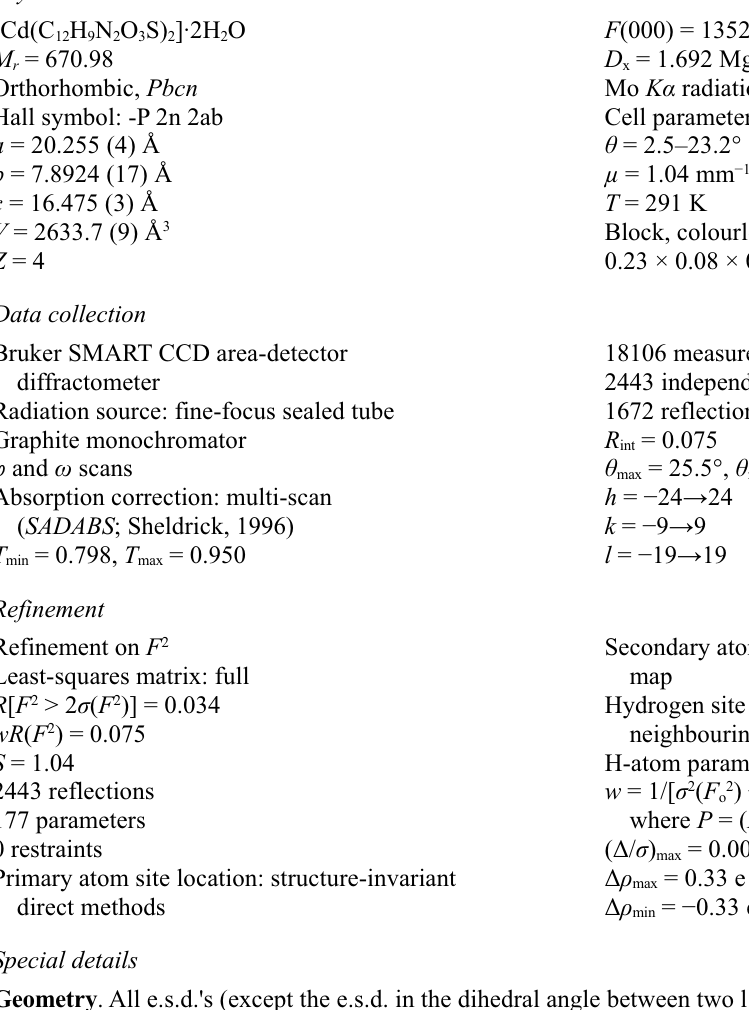
Figure 2 2-D network, as viewed down the c axis. Dashed lines indicate hydrogen bonds. Bis[2-(2-pyridylmethyleneamino)benzenesulfonato- κ 3 N , N ′ , O ]cadmium(II) dihydrate Crystal